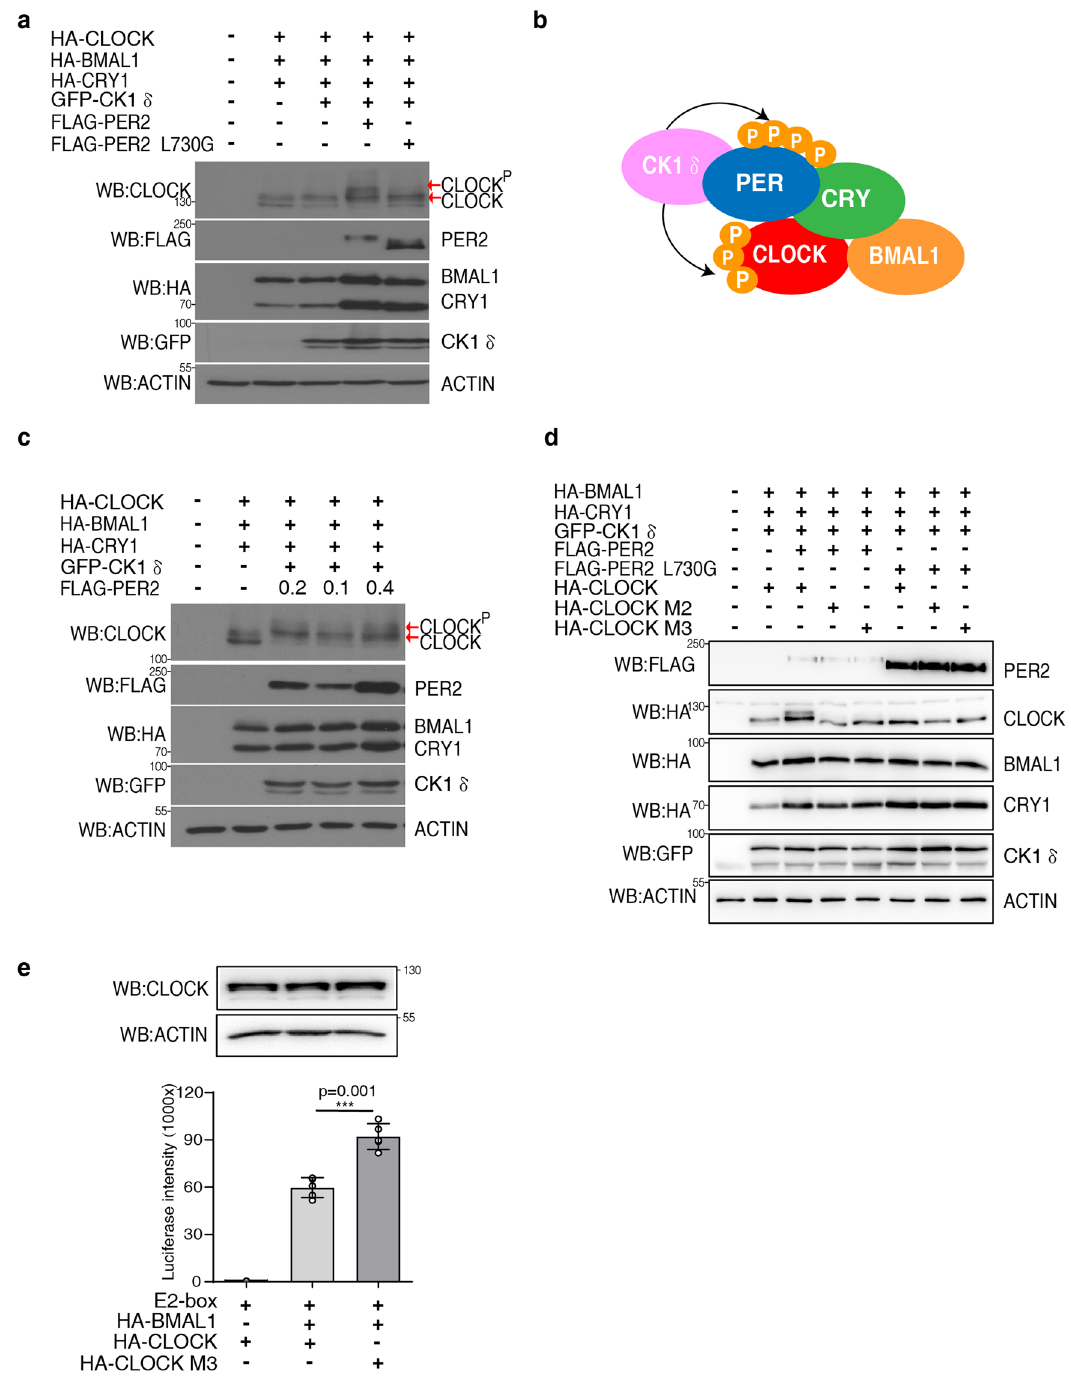
Fig. 3 The PER-CK1 interaction is required for CLOCK hyperphosphorylation which can repress CLOCK-BMAL1 activity. a Western blot analysis showing that hPER2 expression results in hyperphosphorylation of CLOCK but L730G mutation of hPER2 blocks CLOCK hyperphosphorylation. CLOCK, BMAL1, CRY1 and CK1 δ expression plasmids were cotransfected with PER2 or PER2L730G in HEK293 cells. 200 ng of BMAL1, 20 ng of CRY1,400ng of CLOCK, 400 ng of CK1 δ and 400 ng of PER2 or PER2L730G plasmids per 35 mm dish of HEK293 cells. The hyperphosphorylated CLOCK was indicated by the top arrow. Note that the endogenous CLOCK protein was not detected due to its low expression level. Five independent experiments were performed to validate the results. b A diagram depicting the model that PER2 acts as the CK1 scaffold to promote the phosphorylation of PER and CLOCK proteins in the PER-CRY-CLOCK-BAML1 complex. c Hyperphosphorylation of CLOCK is PER expression dose-dependent. The indicated different amounts of hPER2 expression plasmids were used in the transfection. The hyperphosphorylated CLOCK was indicated by the top arrow. Three independent experiments were performed to validate the results. d Mutation of CLOCK phosphorylation sites abolished the PER-dependent CLOCK hyperphosphorylation. The previously identi fi ed phosphorylation CLOCK sites were mutated in the M1 (S427/431/436/437/440/441 to glycine) and M2 (S38/42/S427/431/436/437/440/ 441 to glycine) mutants. Three independent experiments were performed to validate the results. e Mutations of CLOCK phosphorylation sites result in increased expression of the CLOCK/BMAL1-driven E-box controlled luciferase reporter gene. *** p value < 0.001 (two-side t -test). Data are represented as mean ± SD, n = 5. The western blot results of the same experiment were shown